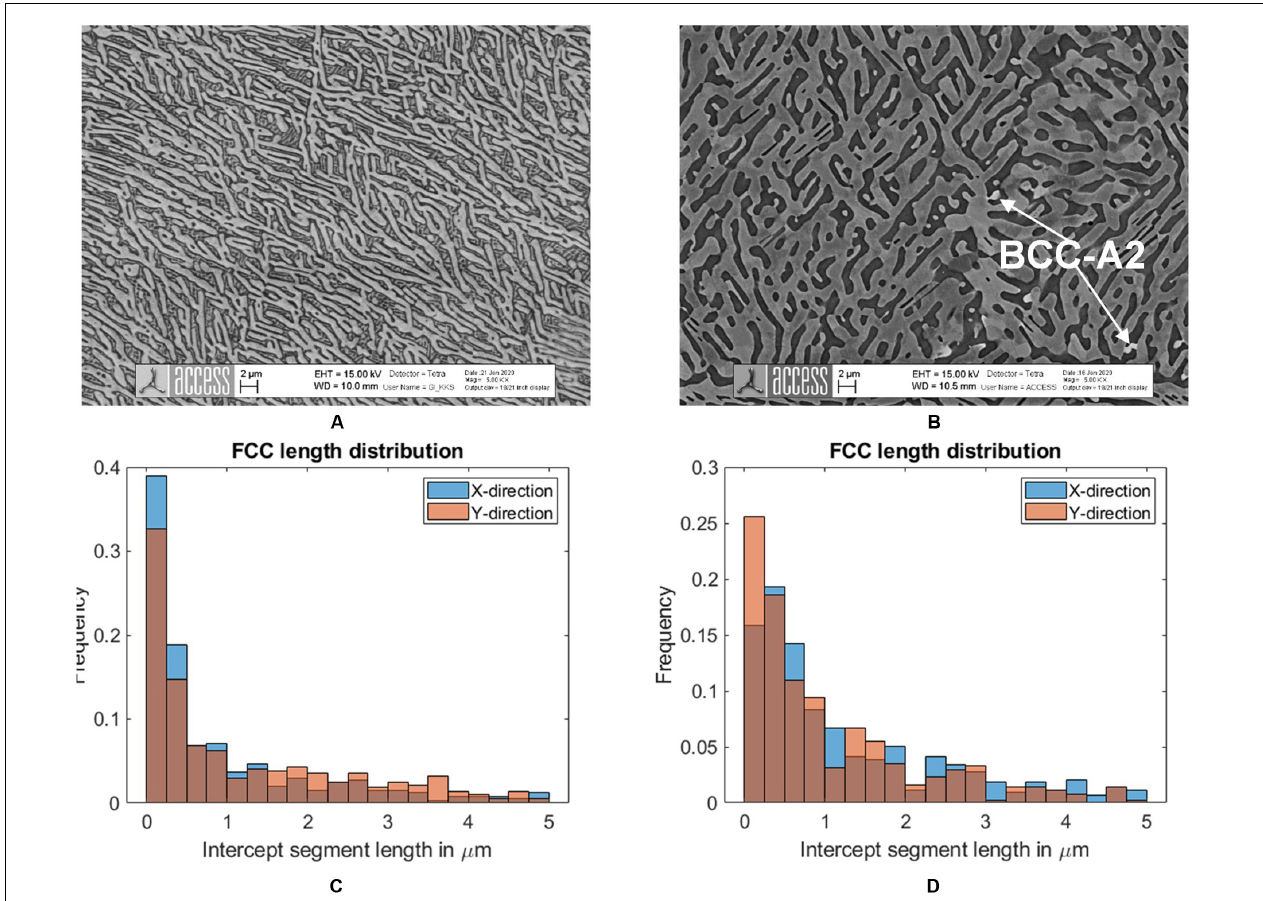
FIGURE 5 | FCC size distribution in sample Mo 2 in as-cast conditions (A,C) and after annealing at 1100 ◦ C for 3 h (B,D) . The size distribution was measured by the line intercept method using both vertical and horizontal lines. TABLE 3 | Phase compositions in Mo 0 and Mo 2 after annealing at 1100 ◦ C/3 h measured by EDS. AlCrFe 2 Ni 2 Al (at.%) Cr